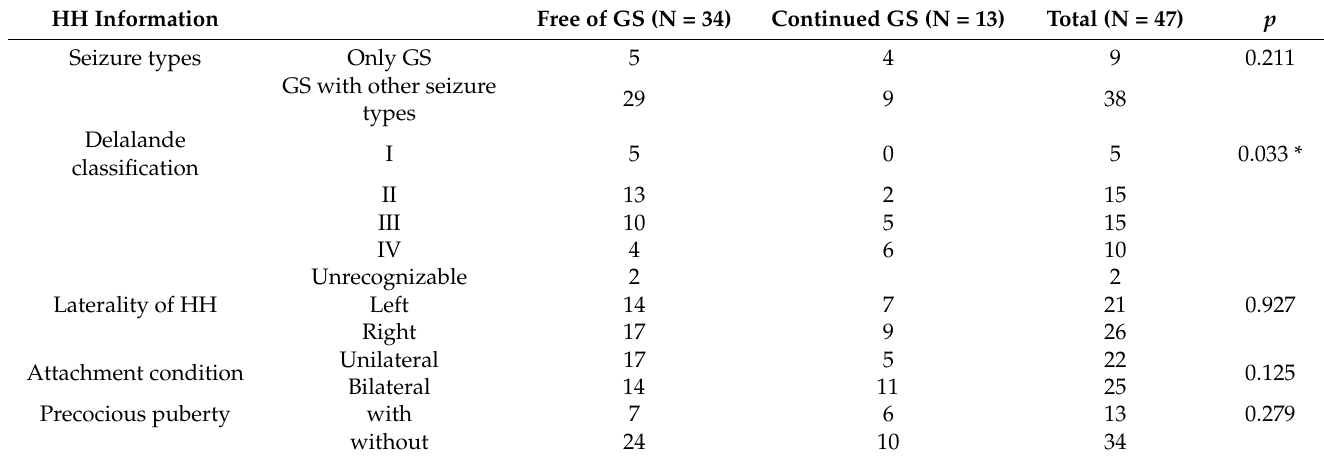
Table 2. HH information.